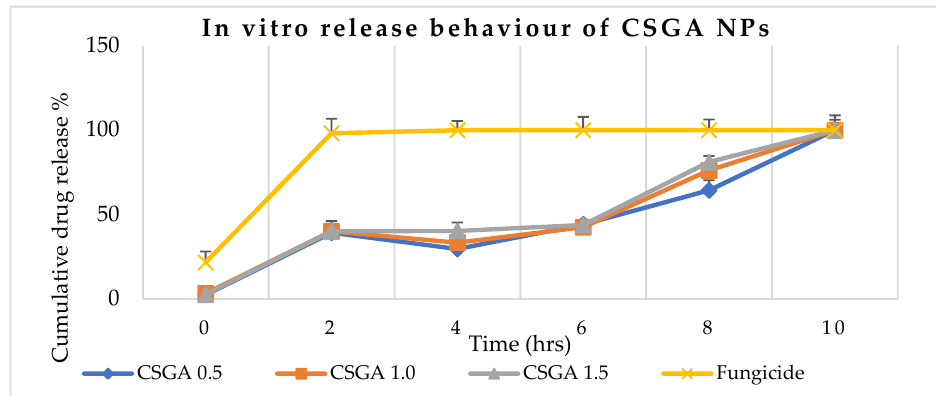
Figure 4. In vitro sustain release of mancozeb from chitosan–gum acacia-conjugated nanoparticles (CSGA). The yellow line represents commercial fungicide, while blue, saffron, and gray represent CSGA-0.5, 1.0, and 1.5, respectively.